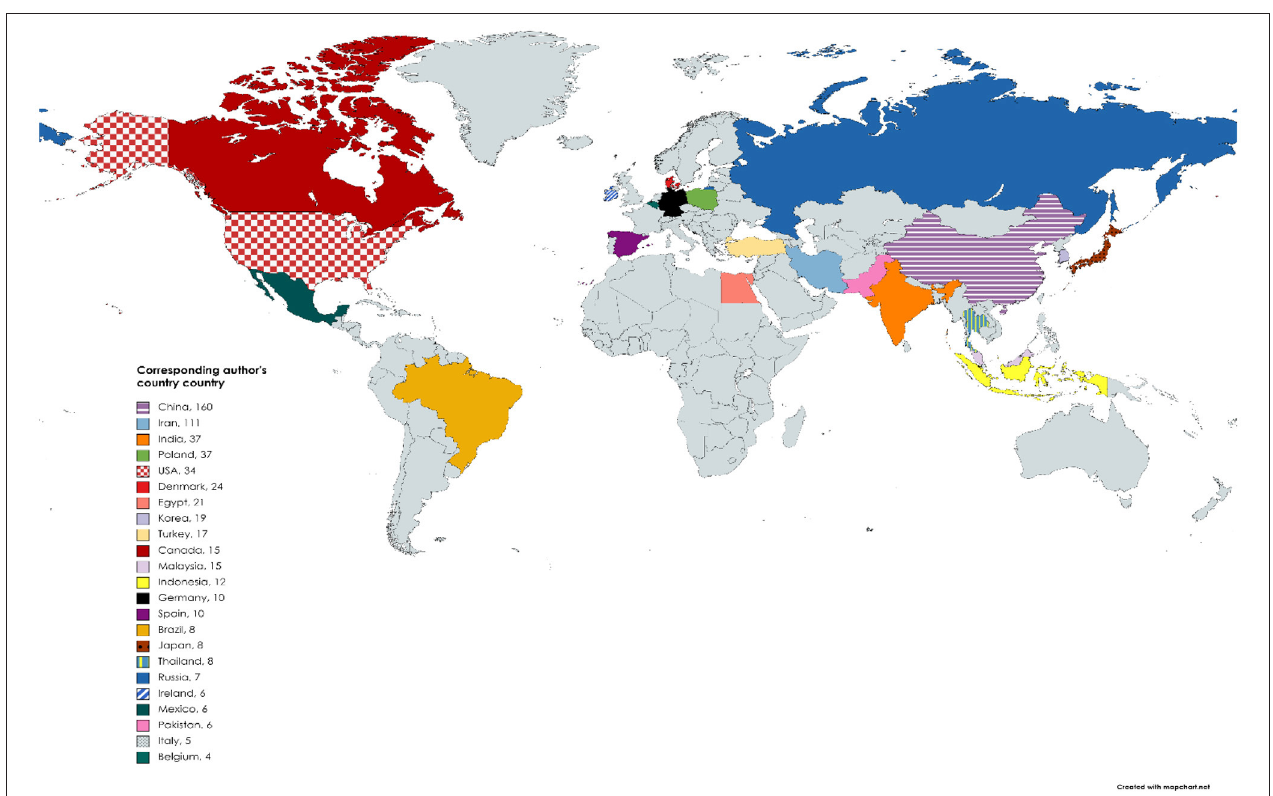
FIGURE 4 | Spatial mapping of the top 20 most productive countries based on the number of research articles on nanotechnology and meat production (Corresponding author’s countries). Gray color covering depicts the areas that are not part of the top 20 countries.